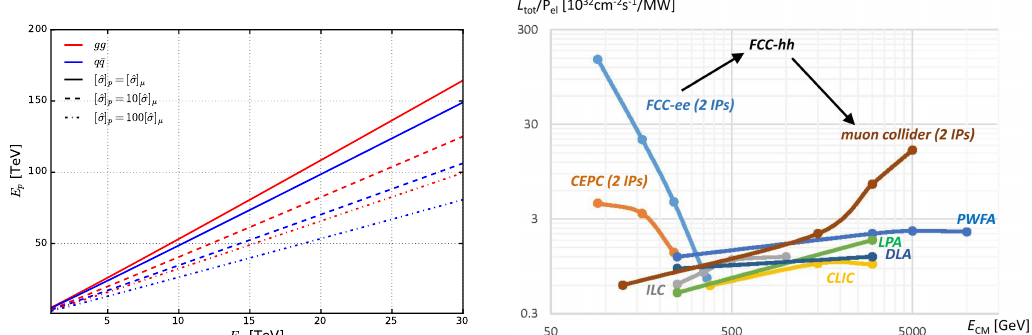
Figure 1: Left: the equivalent center-of-mass energy required at a proton-proton collider to reach the same cross section as at a µ + µ − collider for the neutral-current annihilation of two incoming particles into a new state (reproduced from Ref. [ 1 ] licenced under CC-BY 4.0). Right: total instantaneous luminosity divided by the electric power consumption as a function of the center-of-mass energy for different future accelerator projects and technologies (reproduced from Ref. [ 2 ] licenced under CC BY-NC-ND